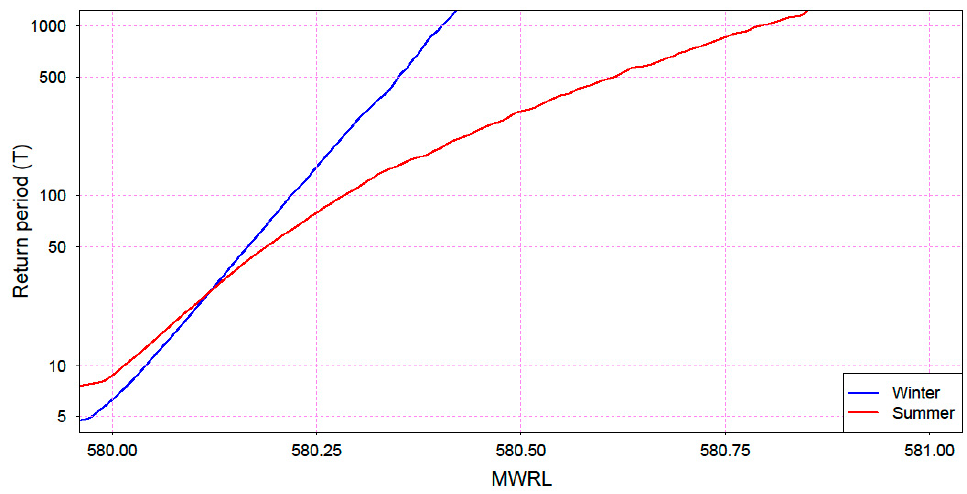
Figure 12. Maximum water reservoir level (MWRL) reached during flood dam routing.